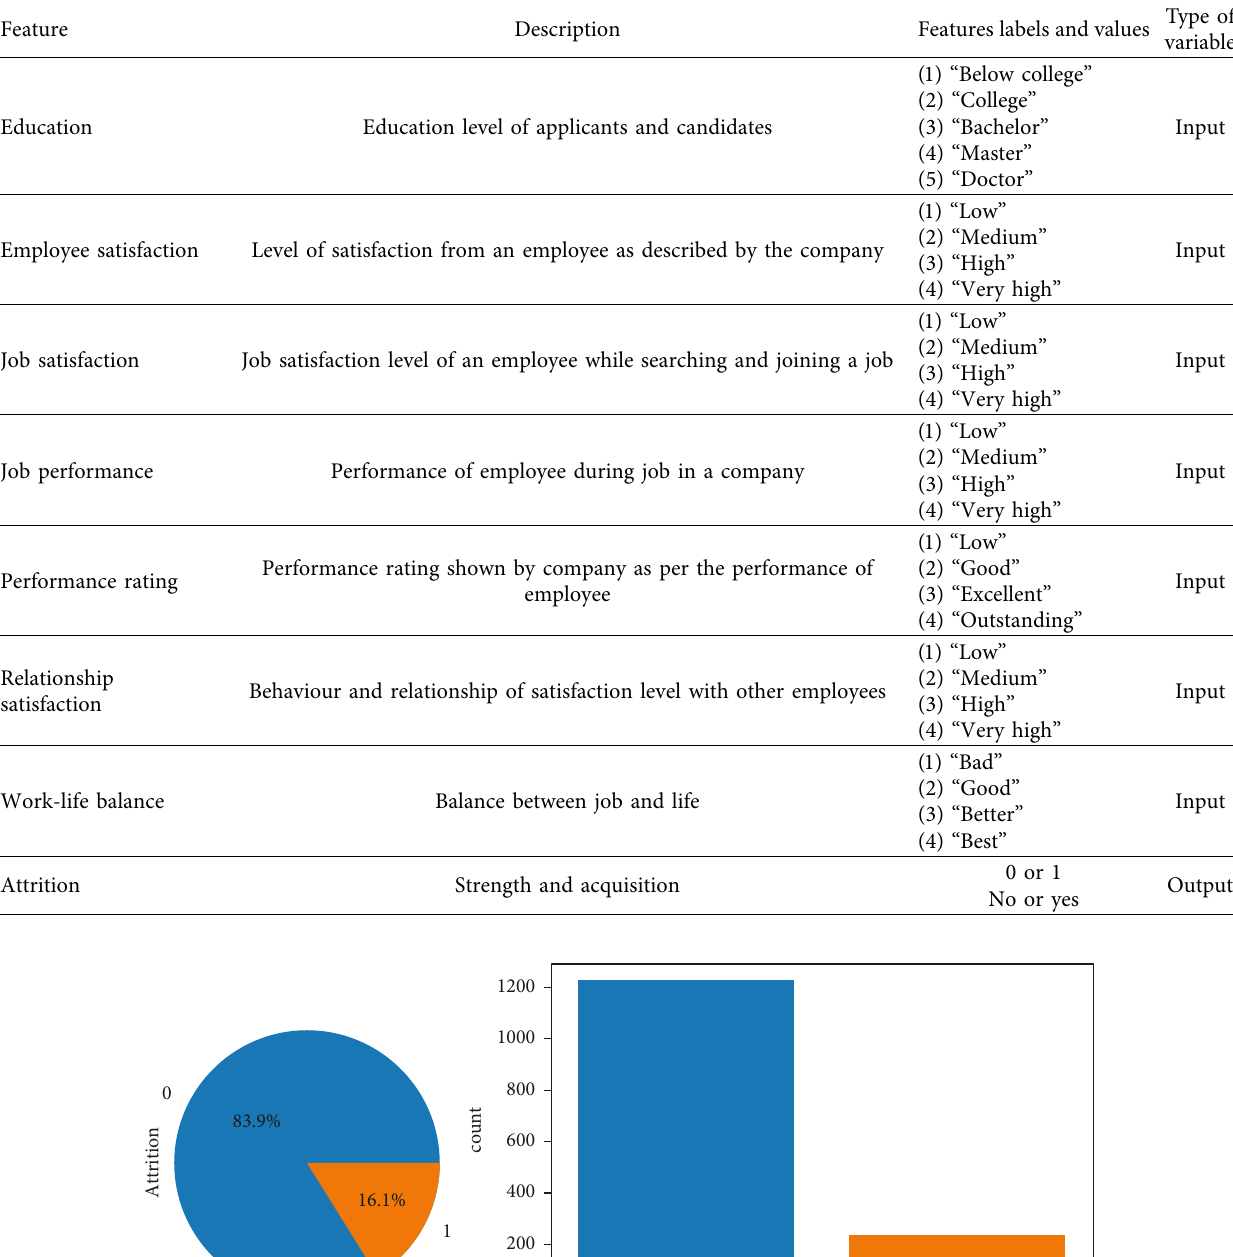
Table 1: Features’ description.